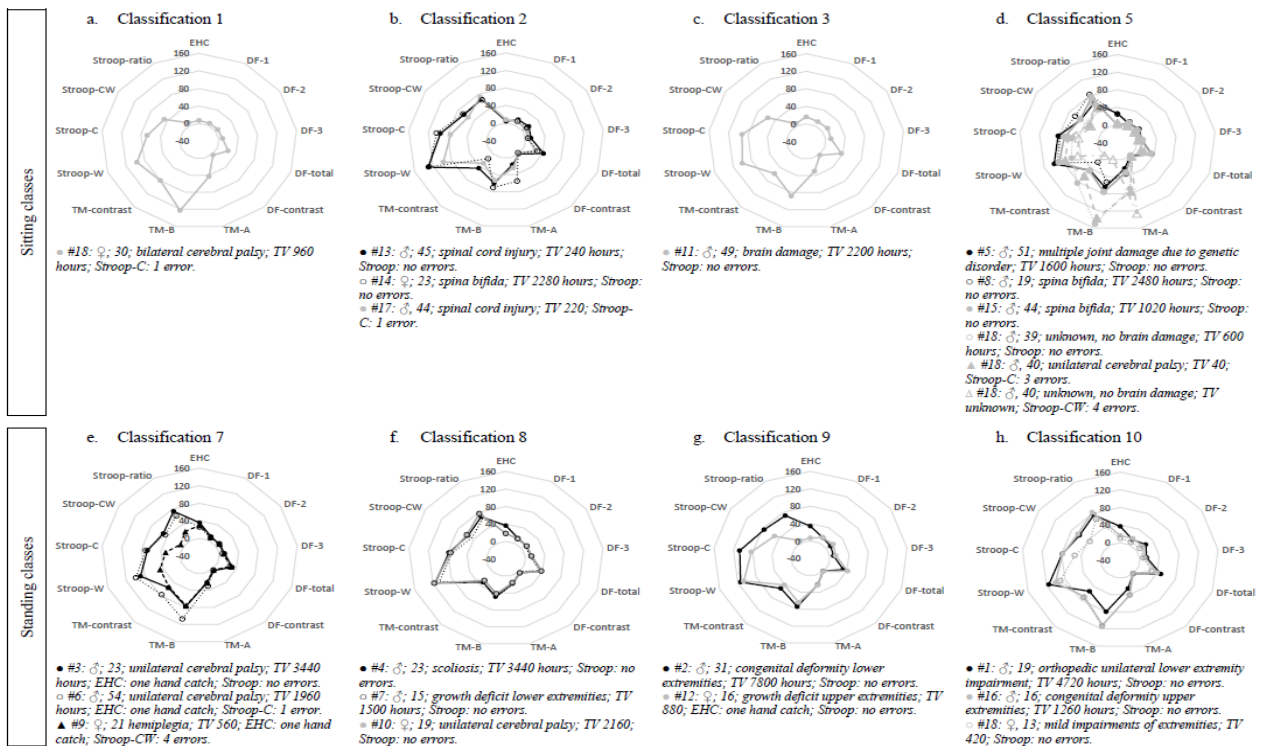
Figure 1. Individual profiles of the included players per classification. Data represent the raw scores per test condition. The results in black refer to the elite players and in grey to the non-elite players. The Stroop-ratio was presented as a percentage. EHC = eye-hand coordination test; DF = D-KEFS Design Fluency test; TM = Trail Making test, Stroop-W = word condition, Stroop-C = colour condition, Stroop-CW = colour-word condition; TV = training volume.